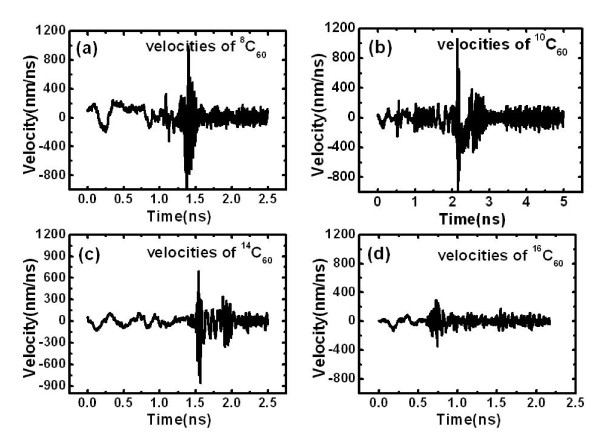
Velocities of C60 consist of different carbon isotopes as a function of time. (a) 8C60, (b) 10C60, (c) 14C60, and (d) 16C60.